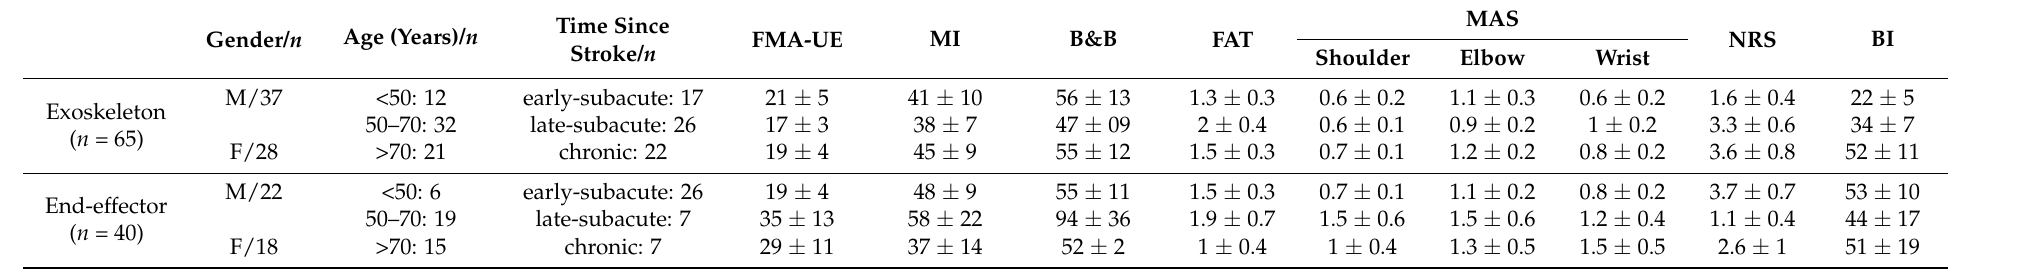
Table 2. Summary of clinical/demographic characteristics (mean ± SD) of the groups at the baseline